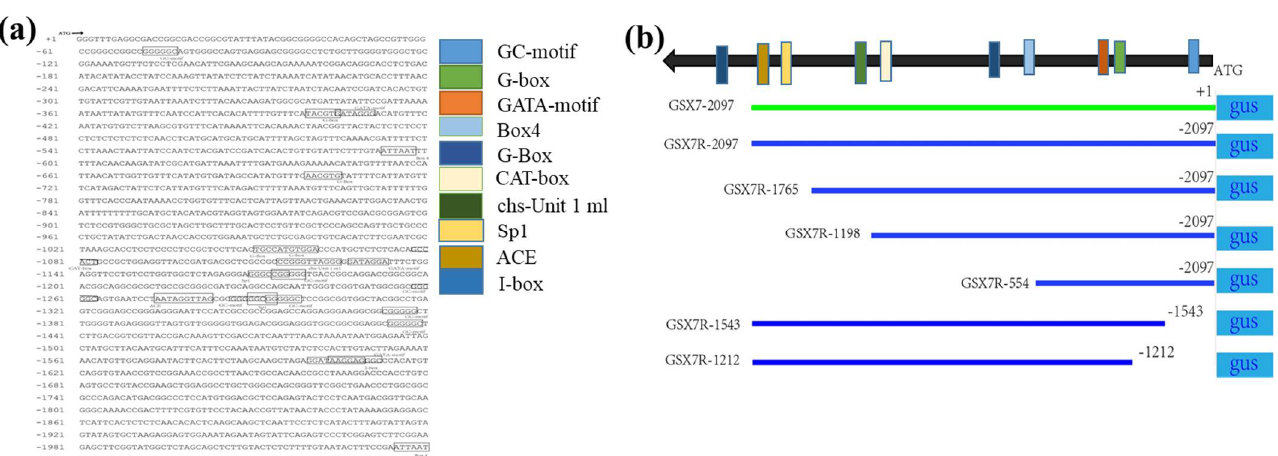
Figure 4. The PCR amplification of promoter GSX7R and its deletions. M: M5 DL2000 plus DNA marker, 1: GSX7R-2097, 2: GSX7R-1765, 3: GSX7R-1198, 4: GSX7R-554, 5: GSX7R-1543, 6: GSX7R-1212. The amplified bands are indicated by red arrows.